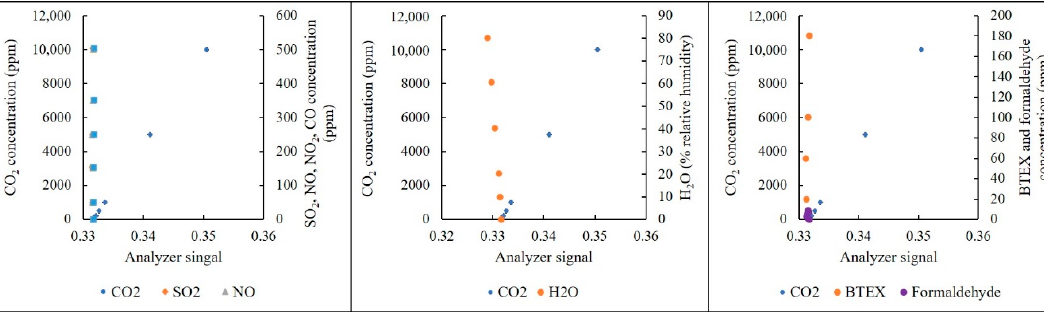
Figure 8. Effects of interference gases on the NDIR analyzer at the ppmv channel. Figure 8. E ff ects of interference gases on the NDIR analyzer at the ppmv